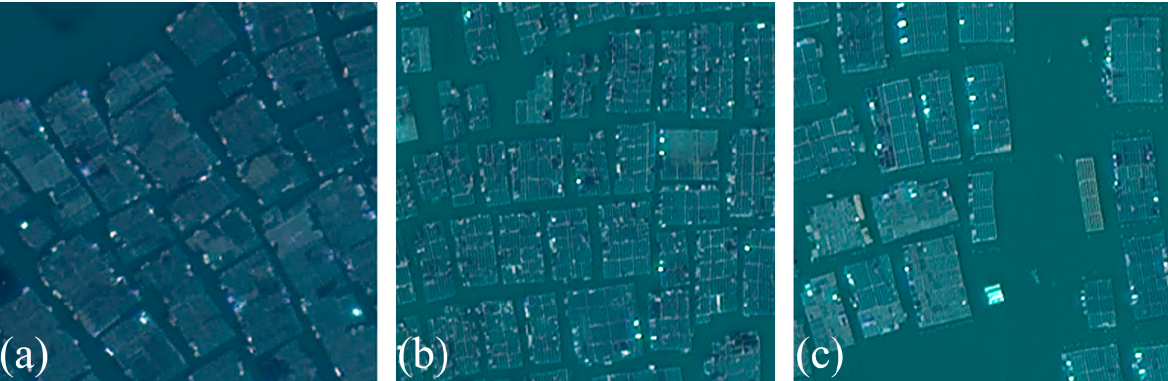
Figure 18. Spectral value of training data and test data after normalization. ( a ) Training data. ( b ) Test A. ( c ) Test B. ( d ) Test C. ( e ) Test D.